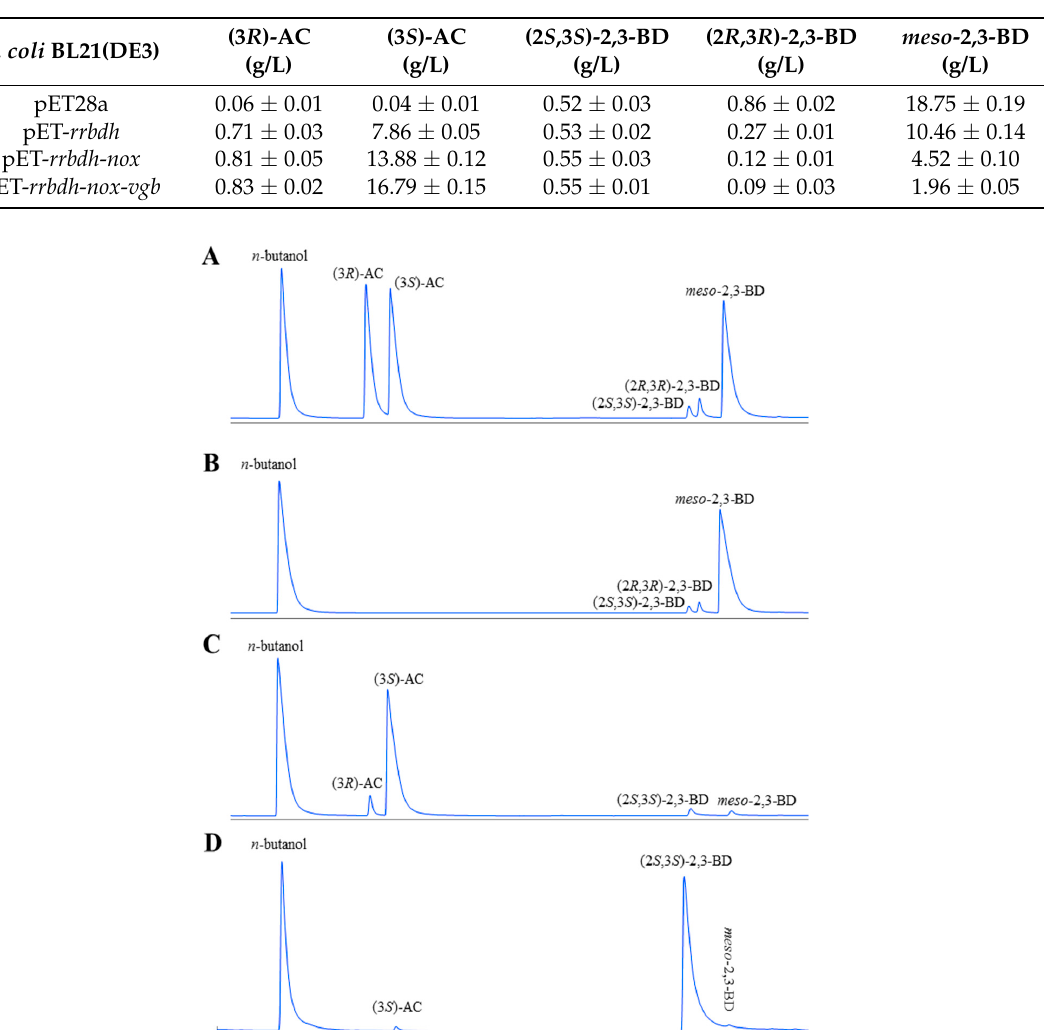
Figure 3. GC analysis of substrates and products in the bioconversion reaction by E. coli (pET- rrbdh - nox - vgb ) and E. coli (pET- ssbdh - fdh ) ( n -butanol was used as the internal standard). ( A ) a mixture of standard chemicals of (3 R /3 S )-AC, (2 S ,3 S )-2,3-BD, (2 R ,3 R )-2,3-BD, and meso -2,3-BD; ( B ) the substrate of 2,3-BD (93.73% meso -2,3-BD, 2.23% (2 S ,3 S )-2,3-BD, and 4.04% (2 R ,3 R )-2,3-BD); ( C ) the product from the substrate of 2,3-BD by induced E. coli (pET- rrbdh - nox - vgb ) cells; ( D ) the product from the substrate of (3 S )-AC produced from meso -2,3-BD by induced E. coli (pET- rrbdh - nox - vgb )